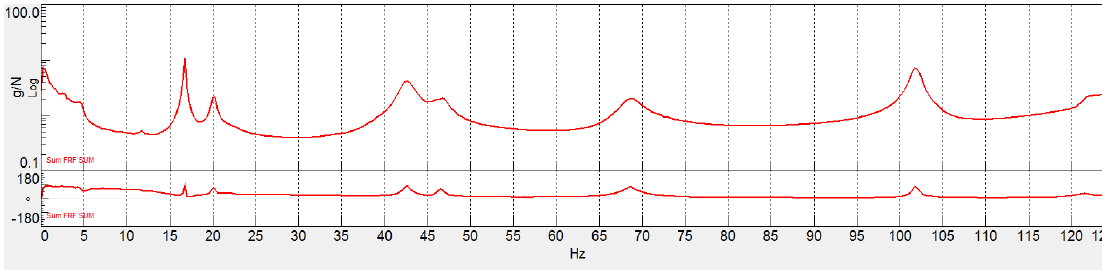
Figure 7. FRF sum resulting from accelerometer data.